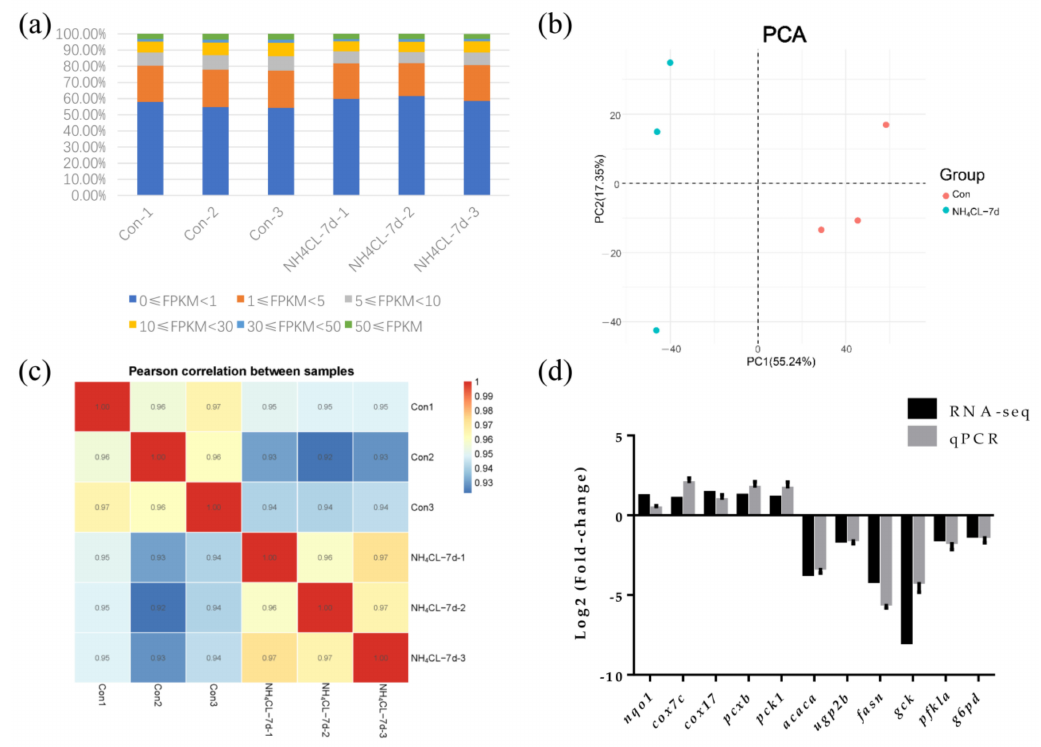
Figure 6. Transcriptomic responses of largemouth bass liver after ammonia exposure for 7d were evaluated by RNA-seq. ( a ) The FPKM value of gene expression levels in two groups. Percentage represents the number of genes with relative abundance in different expression levels and its per- centage in the total number of genes. ( b ) The principal component analysis (PCA) diagram shows the clustering of two groups with axes corresponding to two different principal components. Red represents the control group, blue represents the ammonia nitrogen stress samples for 7 days, and 3 replicate samples were conducted for each group. ( c ) Comparative analysis of sample correlation heatmap between control group and ammonia exposure group. ( d ) Eleven differentially expressed genes were randomly selected for qPCR